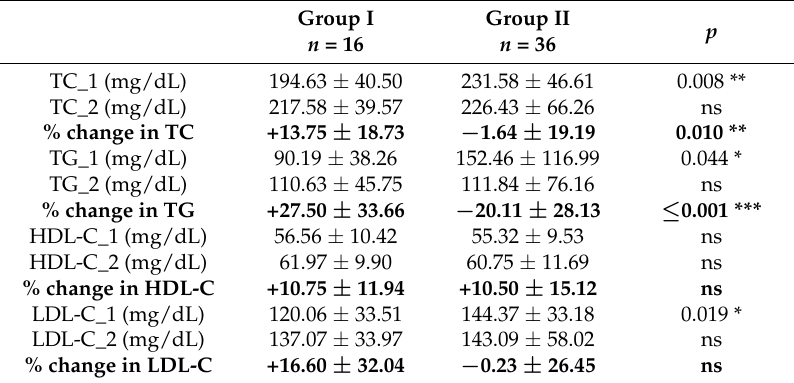
Table 4. Average values of lipid parameters.